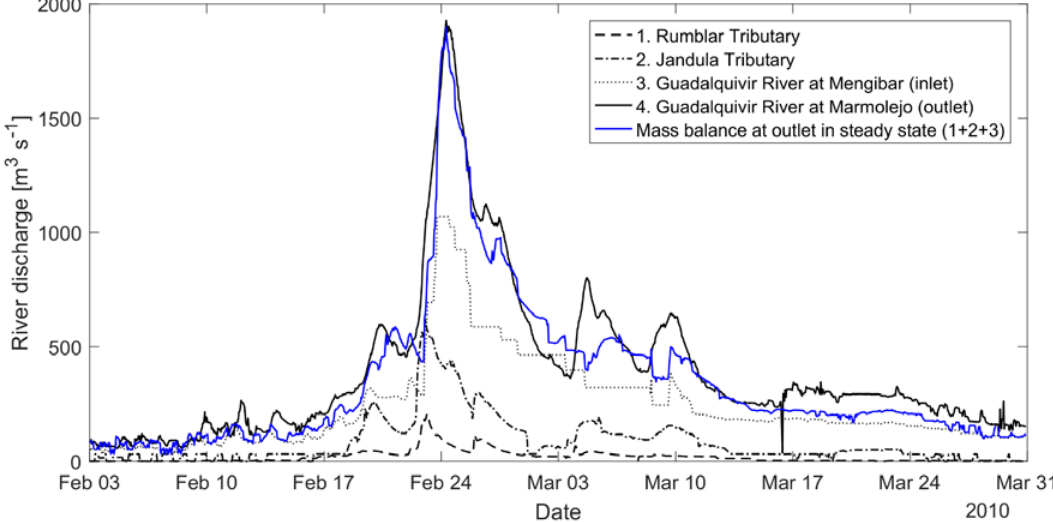
Figure 2. Hydrograph showing river discharges at: Zocueca (1); Encinarejo (2); Mengíbar (3); and Marmolejo (4) dams in February 2010.